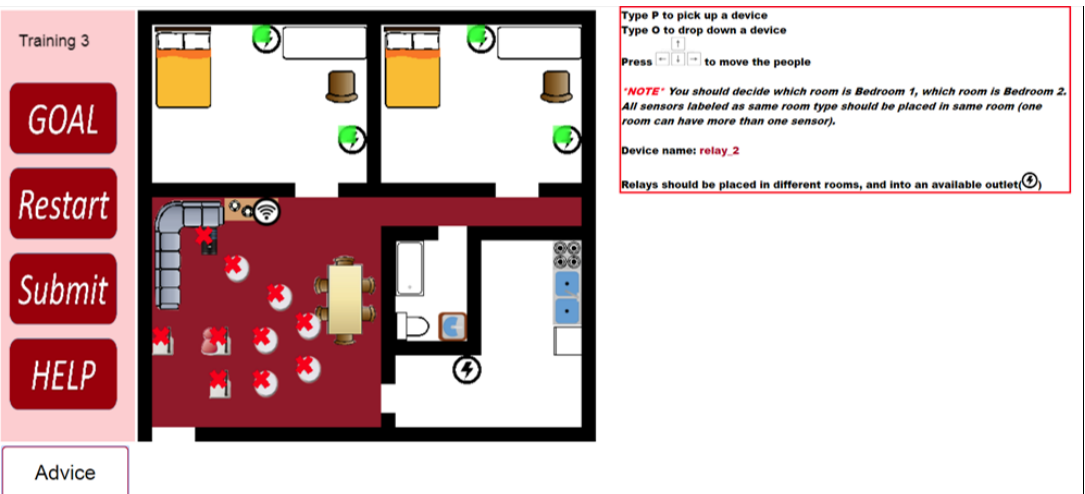
Figure 6. An example of hints for a relay.